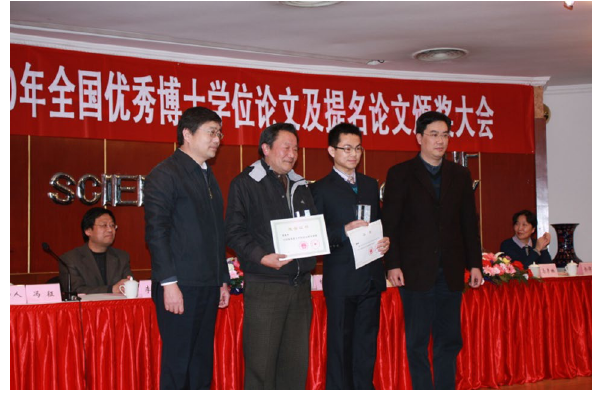
Fig. 3 Jianji Dong ( 董建绩 , second from right), a doctoral student of Huang (second from left), won the National Excellent Doctoral Dis- sertation Award in 2010